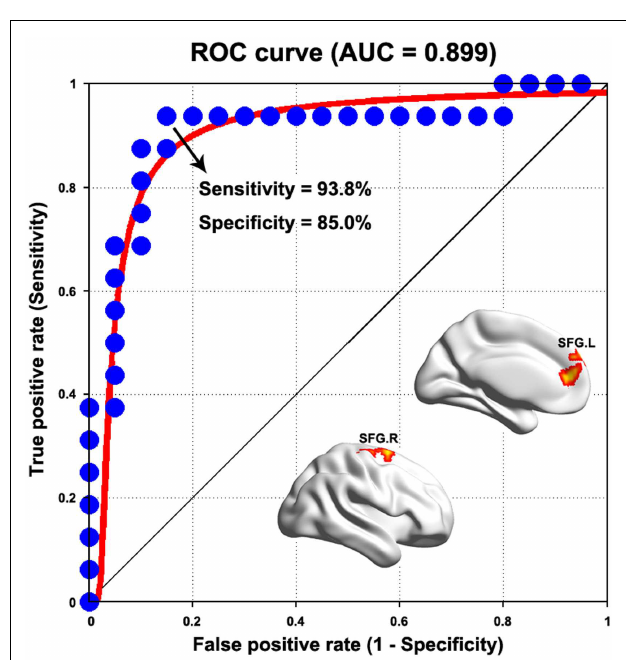
FIGURE 6 | Receiver operating characteristic curve for distinguishing PD patients from healthy controls as a function of varying functional connectivity between the bilateral superior frontal gyrus (SFG) . See Table S1 in Supplementary Material for detailed classification information for weighted degree centrality and other functional